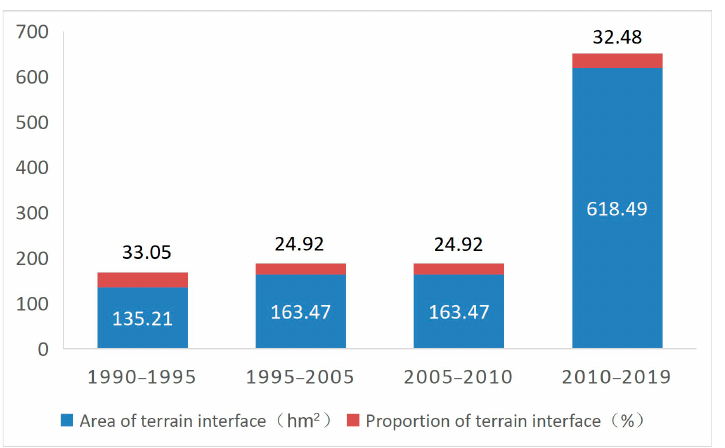
Figure 7. Characteristics of changes in the number of terrain interfaces in Zhulin, 1990–2019. Note: The administrative area of Zhulin did not change during 2005–2010, so the area and proportion of terrain interfaces are the same as during 1995–2005.